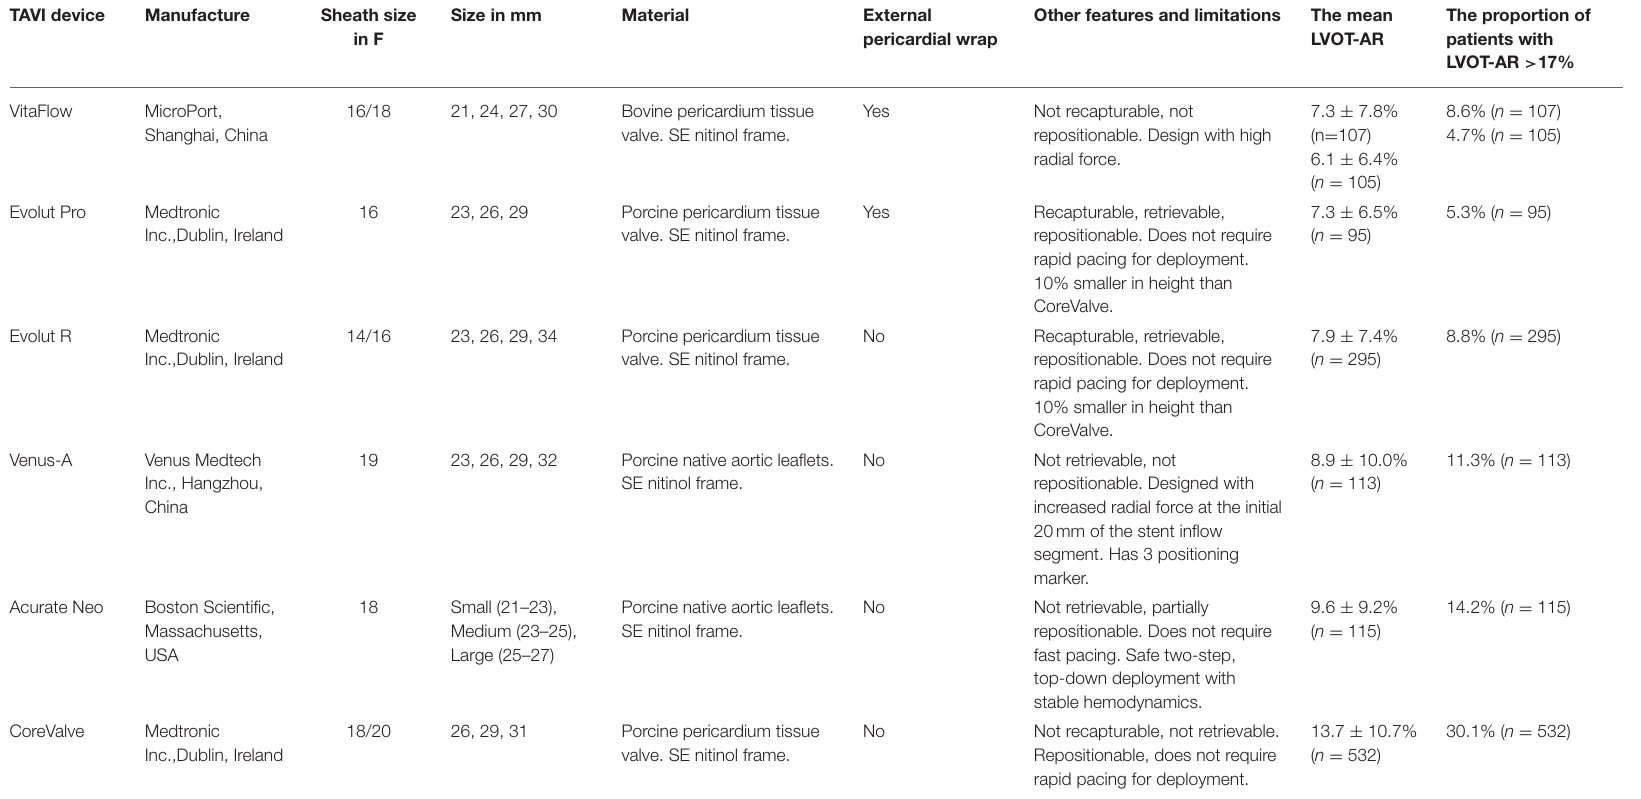
TABLE 2 | Design features of the six THVs and their performance on post TAVR acute AR by videodensitometry analysis. TAVI